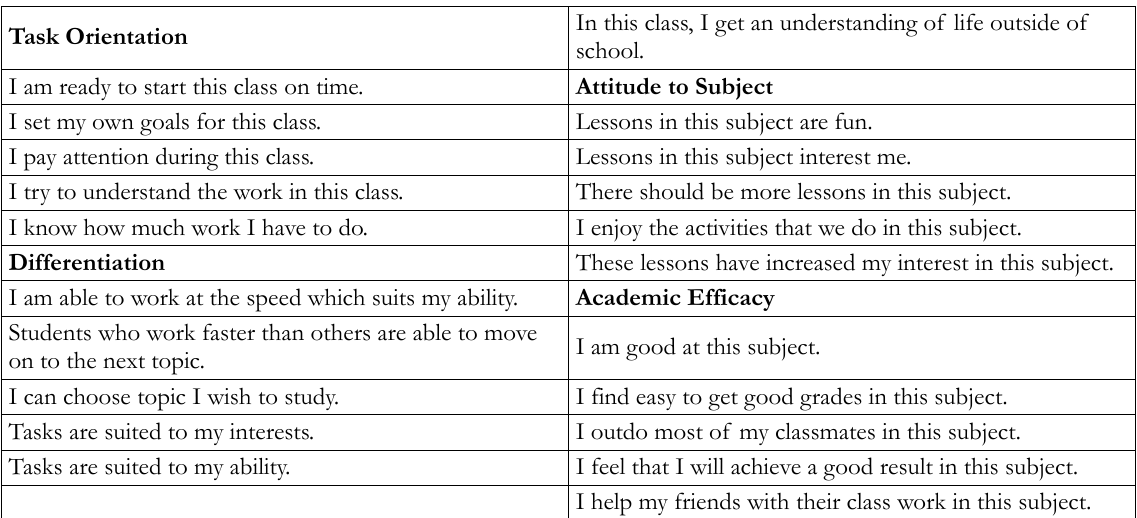
Table 5. Pre-test and post-test questions for students on class, science and course